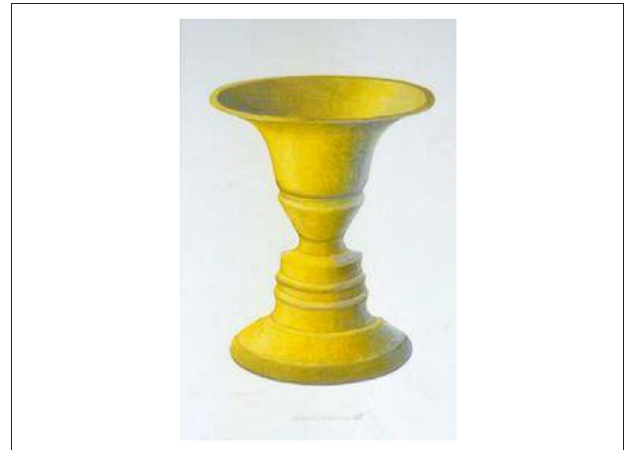
FIGURE 2 | Gold-shaded Rubin’s vase (https://psychology.wikia.org/wiki/ Rubin_vase---retrieved 6/6/2020).